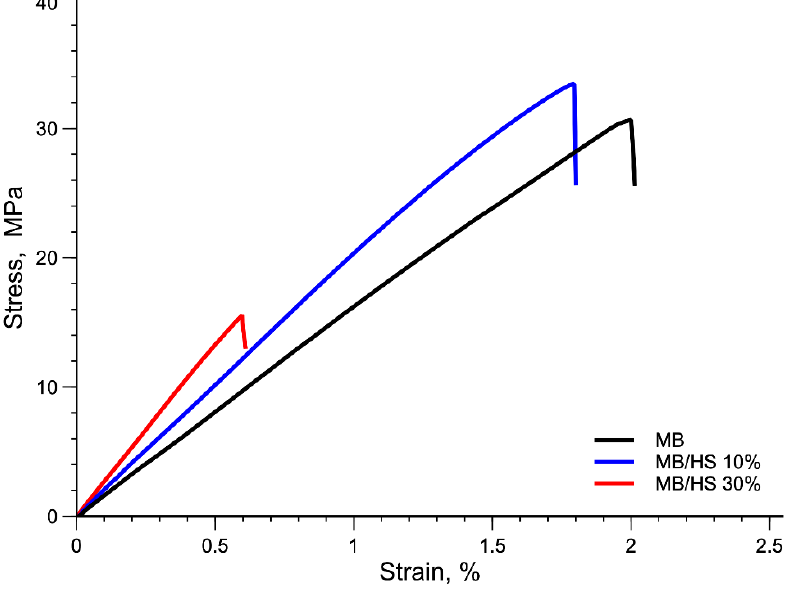
Figure 10. Stress–strain curve of MB and biocomposites.